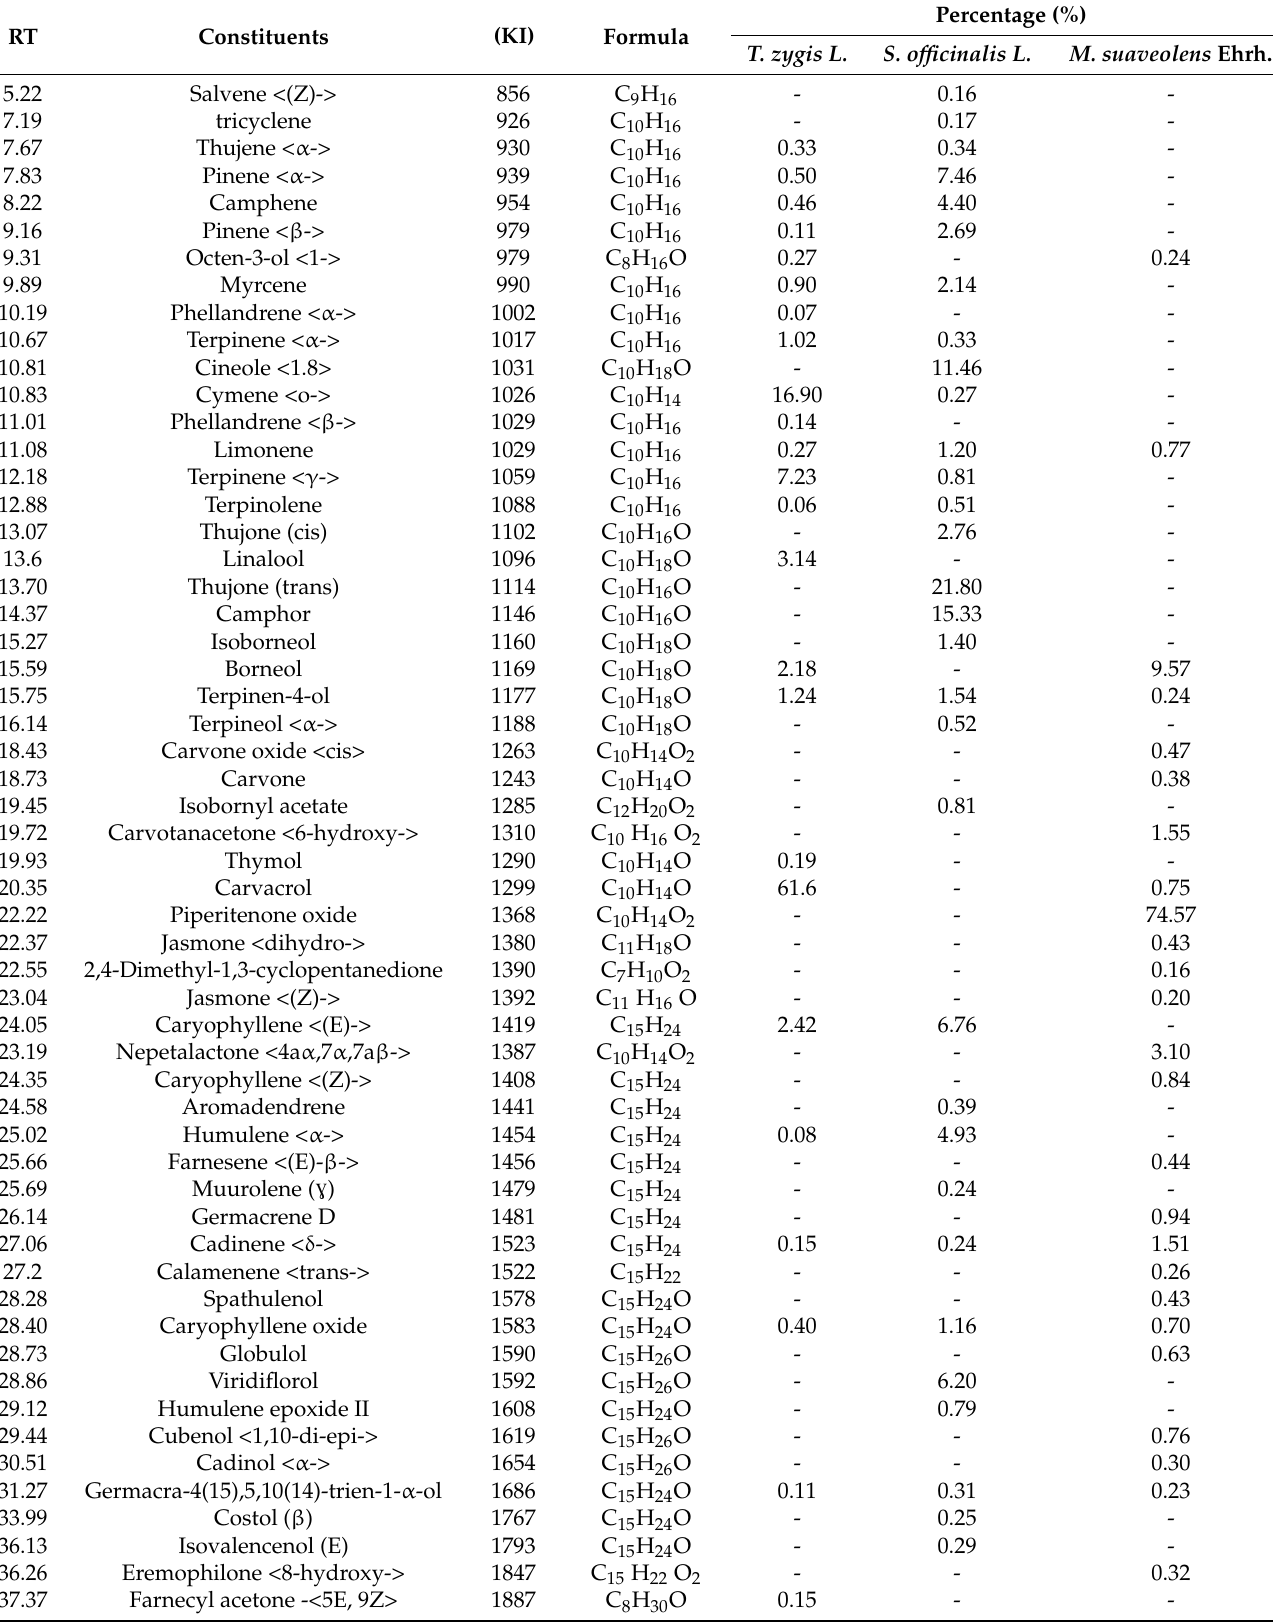
Table 2. Chemical composition of the EOs of T. zygis L., S. officinalis L. and M. suaveolens